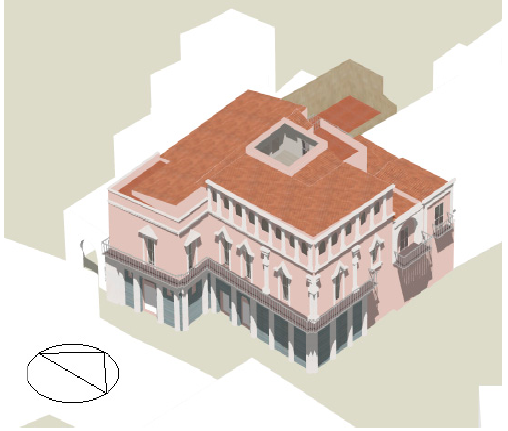
Figure 7. Model of the “Bronzini” building.